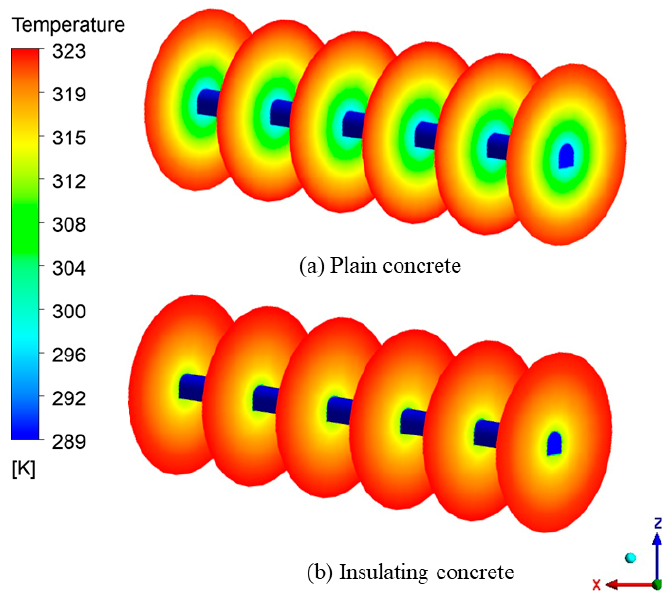
Figure 15. Surrounding-rock temperature field: ( a ) Temperature field of the surrounding rock of the roadway under plain concrete support; ( b ) Temperature field of the surrounding rock of the roadway under insulated concrete support.